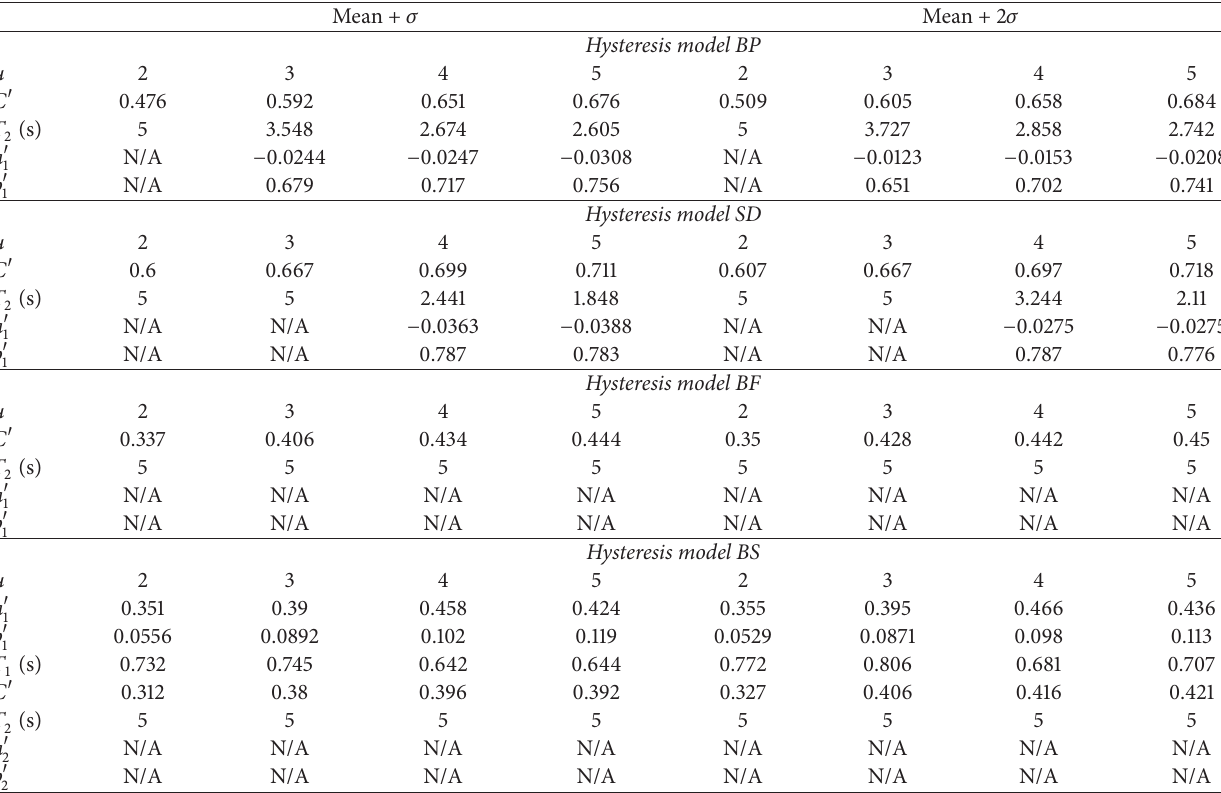
Table 13: HE/IE spectral shape parameters for site class